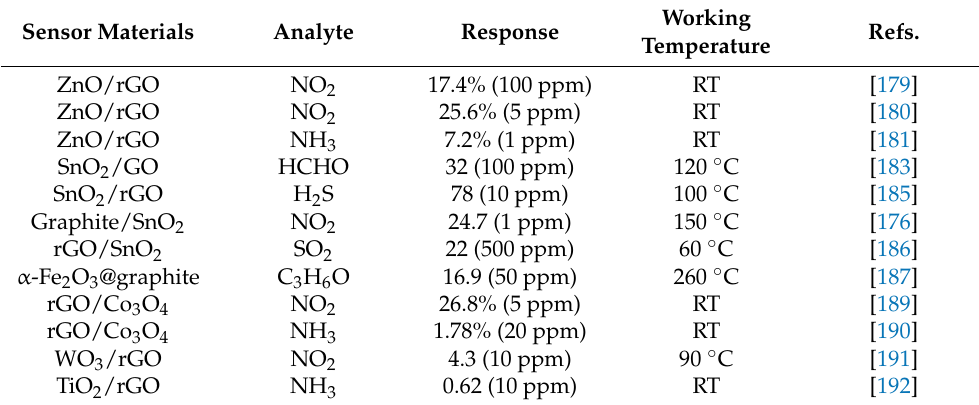
Table 1. Sensors based on MOS modified with graphene/GO/rGO gas sensing performances. Sensor Materials Analyte